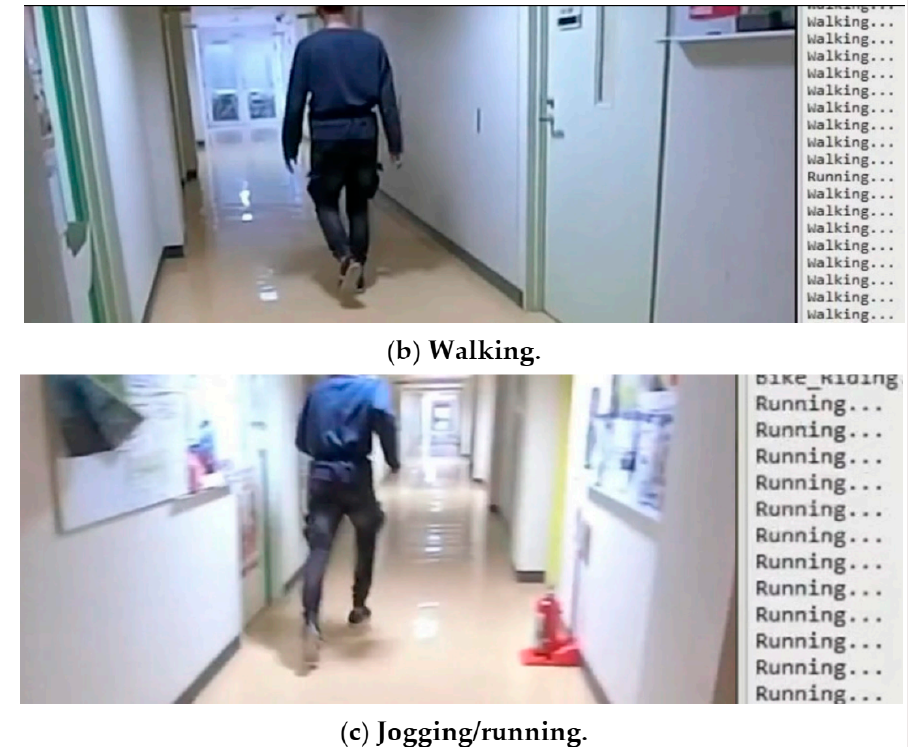
Figure 15. Real-time activity recognition by a computer.